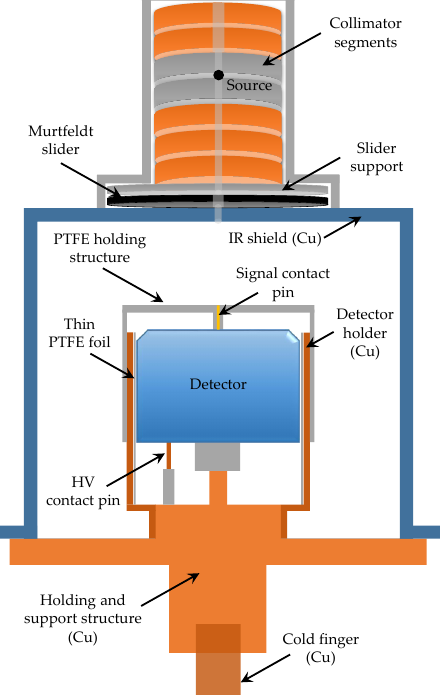
Figure 7. Sectional view of the PPC detector installed in the G ALATEA test facility. The detector is mounted in a copper structure that is cooled via liquid nitrogen. It is surrounded by a copper IR shield. For the scan measurements presented in this manuscript, the detector top surface was irradiated by a radioactive source installed in the top collimator above the IR shield. For reasons of visual clarity, the side collimator of G ALATEA , not relevant for this work, is not shown. Data were acquired with a Struck 14-bit SIS3316 flash ADC (FADC) digitizing the analog signals from the charge sensitive amplifier with a sampling frequency of 250 MHz. For every signal, 5000 samples corresponding to a total waveform trace length of 20 µs were